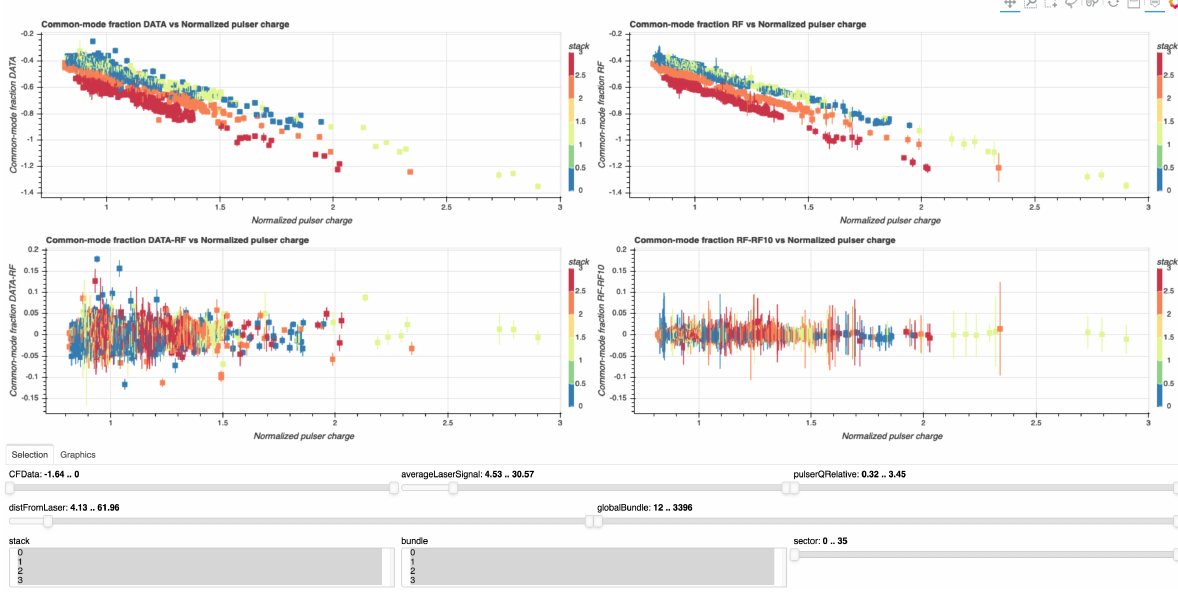
Figure 4. Illustration of the RootInteractive tool. Data ( top left ), comparison of the data to RF predictions ( top right ) and difference between the data and RF predictions ( bottom row